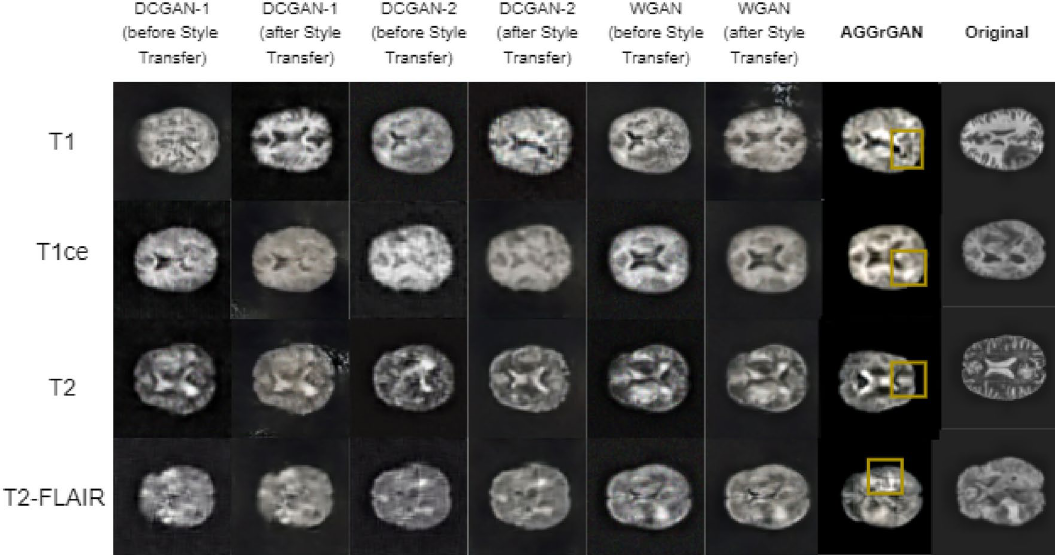
Figure 4. Sample generated images in the BraTS 2020 dataset 16 where each row represents images of the same class and each of the six leftmost columns represents images generated by the same method (tumor region produced by the AGGrGAN model is marked) and the rightmost column represents the original